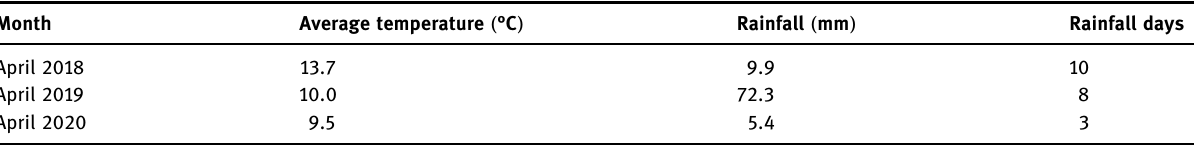
Table 3: Average temperature, rainfall, and number of rainfall days in Krakow in April 2018 – 2020